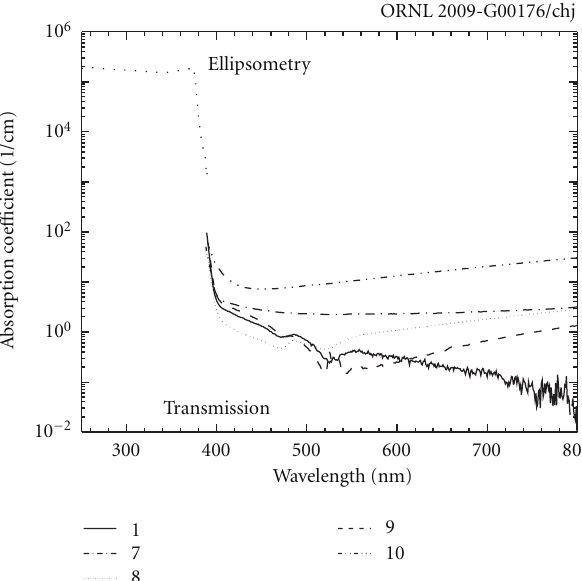
Figure 13: The estimated depletion width for ZnO single crystals as a function of the carrier concentration at the semiconductor- electrolyte interface for three di ff erent built-in potentials (V versus SCE).